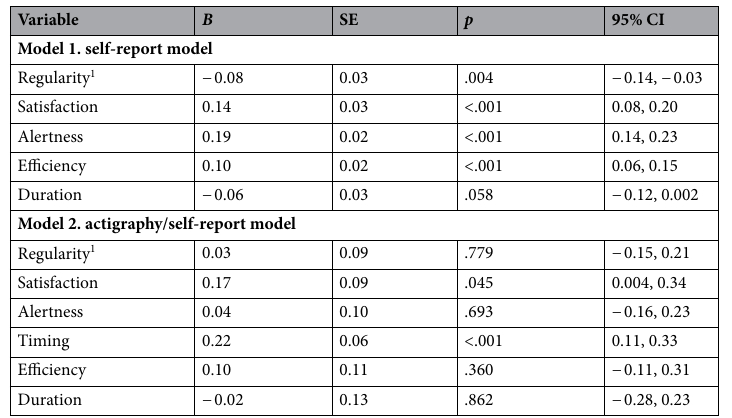
Table 2. Results from unadjusted models with individual sleep health dimensions and the risk of heart disease. 1 For each sleep health dimension, higher scores indicated poorer sleep (i.e., irregularity, poorer satisfaction, lack of alertness, inefficiency, later midpoint timing, and shorter duration). All sleep dimensions were treated continuously and z-scored, then entered simultaneously in the same model. The beta coefficients from this table were used to create the weighted-regression sleep health composites: Self-Report Weighted Sleep Health Composite = ( − 0.08 ∗ Regularity ) + ( 0.14 ∗ Satisfaction ) + ( 0.19 ∗ Alertness ) + ( 0.10 ∗ Efficiency ) + ( − 0.06 ∗ Duration ) . Actigraphy/self-report Weighted Sleep Heath Composite = ( 0.03 ∗ Regularity ) + ( 0.17 ∗ Satisfaction ) + ( 0.04 ∗ Alertness ) + (cid:31) 0.22 ∗ Timing (cid:30) + ( 0.10 ∗ Efficiency ) + ( − 0.02 ∗ Duration )